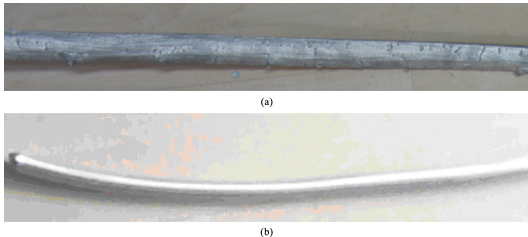
Figure 9. The rods processed by ES die with different extrusion ratios: (a) 11.6 and (b) 28.